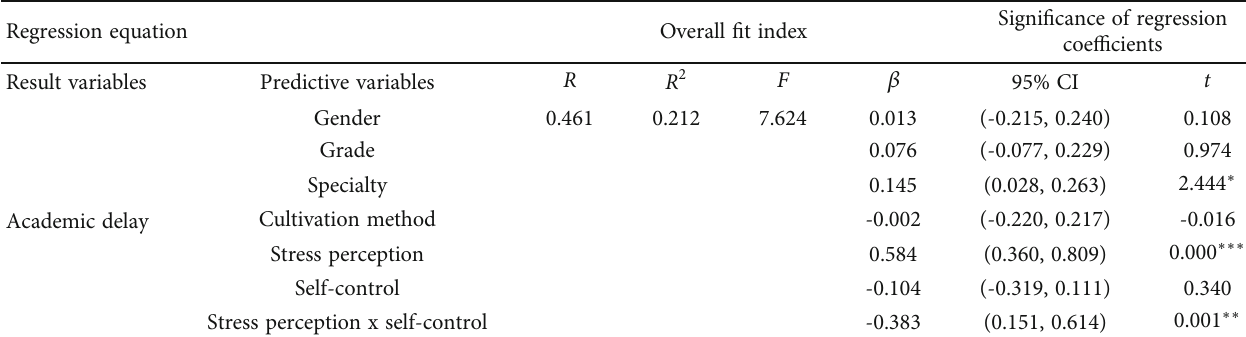
Table 5: Tests of moderating e ff ects of self-control.